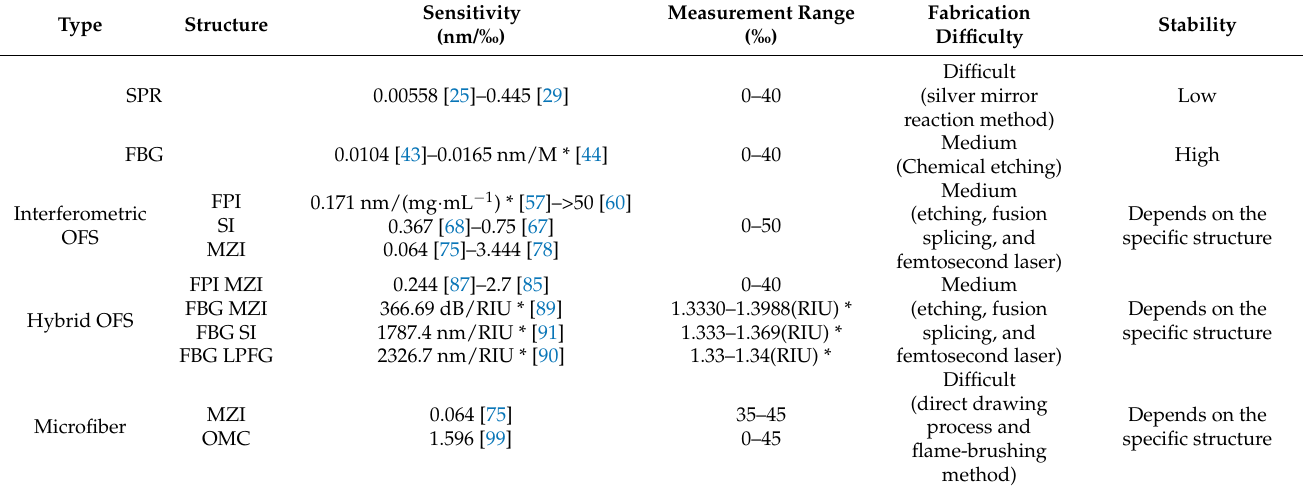
Table 10. Comparison of different